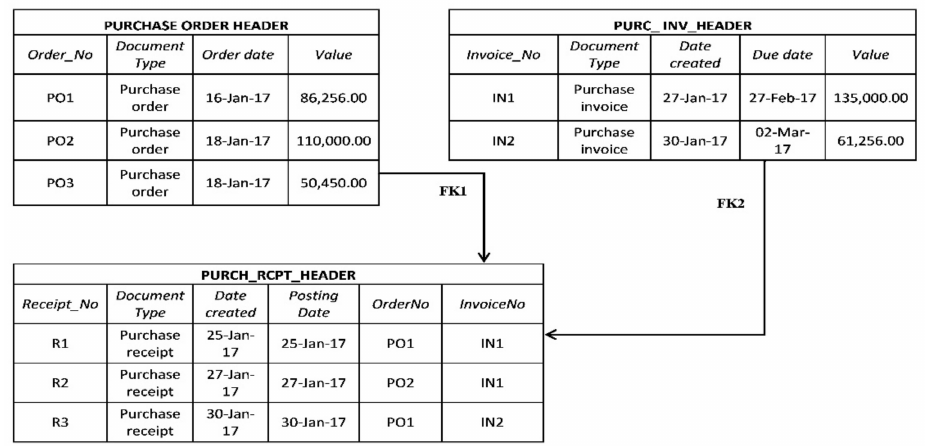
Figure 1. A simplified example of a purchasing